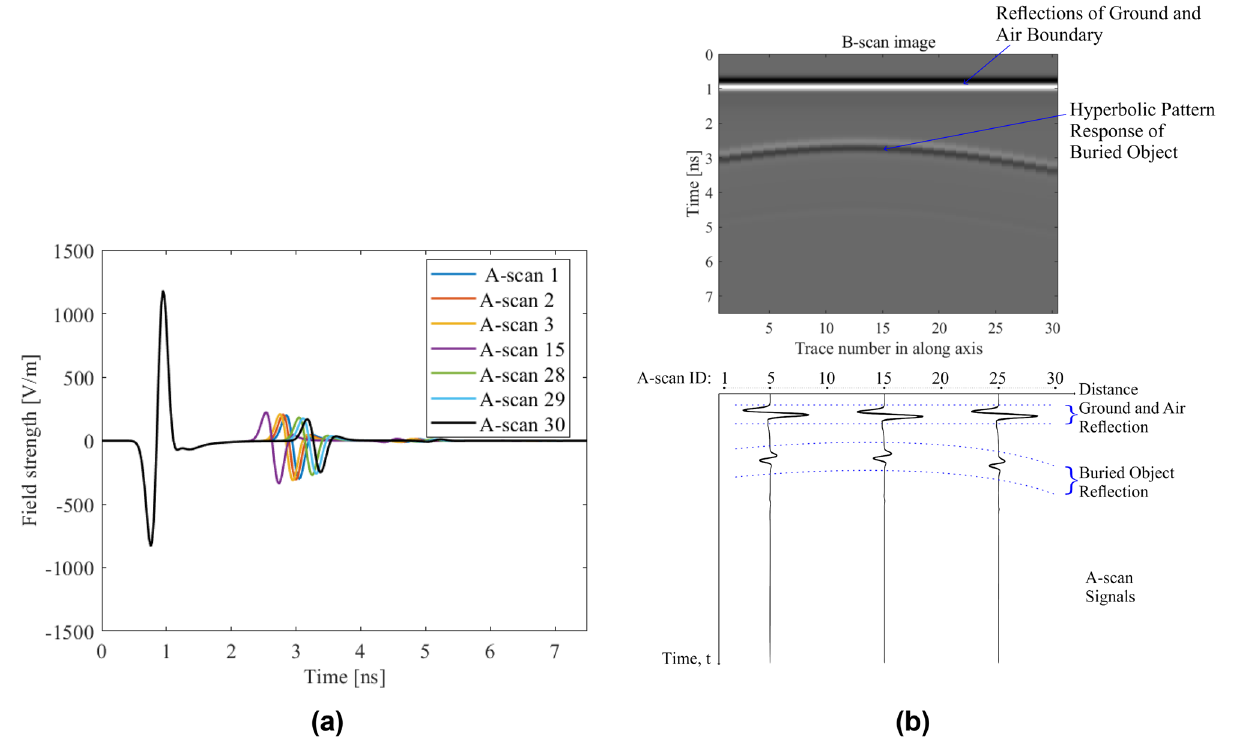
Figure 3. Signals obtained from the GPR model: ( a ) exemplary samples of raw A-scan signals from the test object set at D = 177 mm, P = 175 mm, and R = 19 mm; ( b ) B-scan image construction for the same test